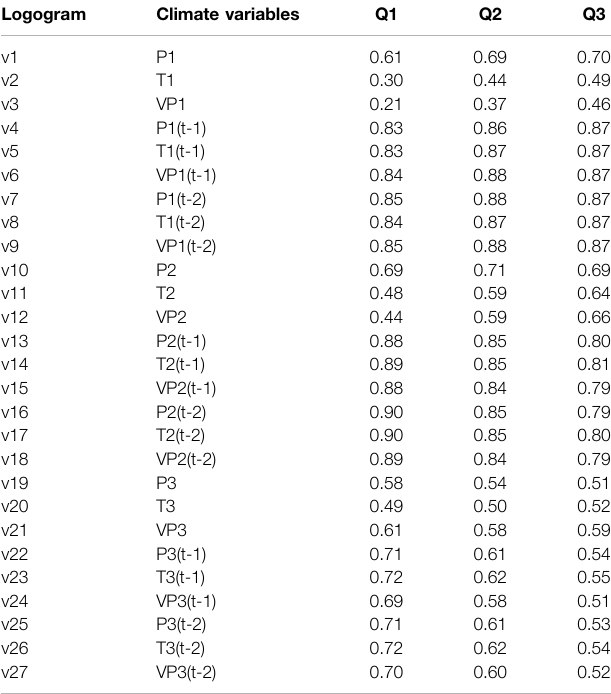
TABLE 2 | Abbreviations and descriptions of predictors and predicated factors in